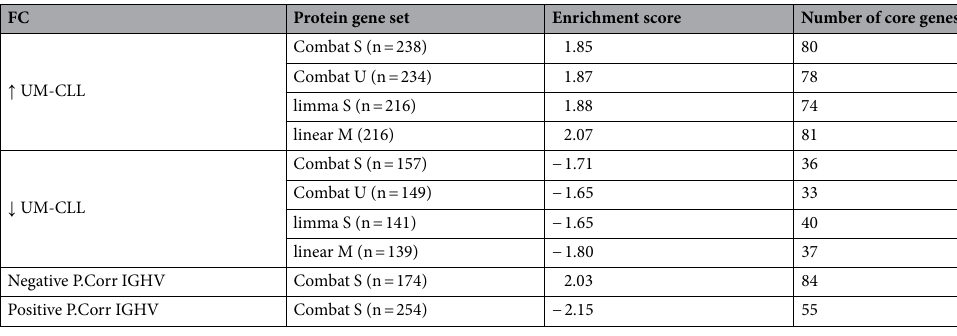
Table 2. Normalised enrichment scores and numbers of core genes for the Gene Set Enrichment Analysis (GSEA) of SWATH-MS proteomics data and mRNA expression data. GSEA was used to compare an mRNA ranked t-statistic gene expression signature (GEO database, accession number GSE28654) 21 , representing genes found to be differentially expressed between UM-CLL and M-CLL samples (≤ 10% FDR, n = 3008), to proteins found to be differentially expressed (≤ 10% FDR) in batch corrected (by Combat supervised (Combat S), Combat unsupervised (Combat U), limma supervised (limma S) or limma with batch information incorporated into the linear model design (linear M)) SWATH-MS data. In addition, the mRNA signature was compared to proteins found to be significantly positively or negatively correlated to the percentage of IGHV mutation by partial correlation analysis (P. Corr) after Combat S batch correction (FDR < 10%). All GSEA results were significant (0%